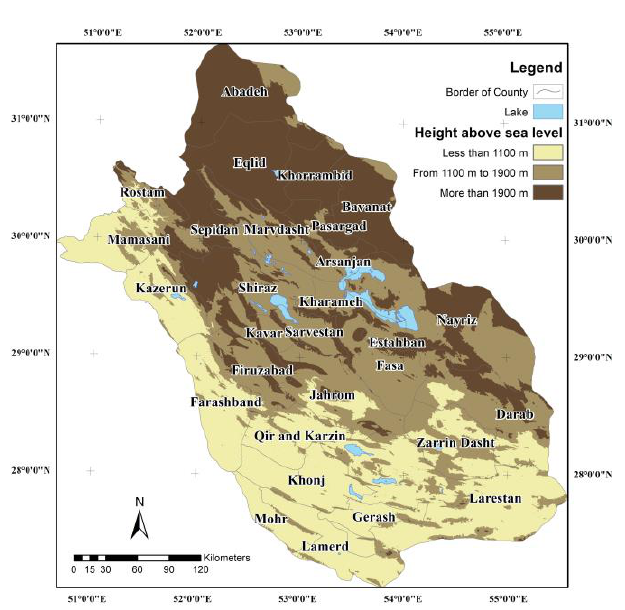
Fig. 13. Altitude Map of Fars Province